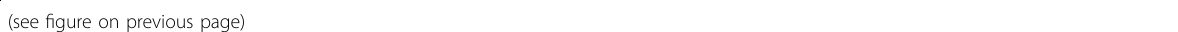
Fig. 3 Humanized anti-RGMa antibodies suppress MPTP-induced neuronal loss and in fl ammation. A Schematic representation of the timeline of MPTP injection and humanized antibody treatment. B Immuno fl uorescent staining for TH in the SN at 2 days (top), 7 days (middle), and 21 days (bottom) after the last MPTP injection. Scale bar, 200 μ m. C Changes in the numbers of TH-positive cells in the SN of MPTP-injected mice with anti- RGMa antibody or Palivizumab (as control) treatment at 21 days after the last MPTP injection. n = 9 – 10. * P < 0.05, Welch ’ s t test. D , E Stereology counts of TH-positive neurons in the SN from mice with anti-RGMa antibody or control (Palivizumab) treatment at 2 days ( D ) and 7 days ( E ) after the last MPTP injection. n = 5 – 6 ( D ), n = 5 – 7 ( E ). * P < 0.05, ** P < 0.01, *** P < 0.005, two-way ANOVA with Bonferroni multiple comparison test. F Immuno fl uorescent staining for Nissl in the SN at 21 days after the last MPTP injection. Scale bar, 200 μ m. G Stereology counts of Nissl-positive neurons in the SN from mice with anti-RGMa antibody or control (Palivizumab) treatment at 21 after the last MPTP injection. n = 4 – 6. ** P < 0.01, *** P < 0.005, two-way ANOVA with Bonferroni multiple comparison test. H Immuno fl uorescent staining for Iba1 in the SN at 2 days (top), 7 days (middle), and 21 days (bottom) after the last MPTP injection. Scale bar, 100 μ m. I Changes in the numbers of Iba1-positive cells in the SN of MPTP- injected mice with anti-RGMa antibody or Palivizumab treatment at 21 days after the last MPTP injection. n = 5 – 6. * P < 0.05, Student ’ s t test. J , K Stereology counts of Iba1-positive neurons in the SN of mice with anti-RGMa antibody or control (Palivizumab) treatment at 2 days ( J ) and 7 days ( K ) after the last MPTP injection. n = 5 – 6 ( J ), n = 5 – 7 ( K ). * P < 0.05, one-way ANOVA with Bonferroni multiple comparison test. L Immuno fl uorescent staining for cleaved caspase3 in the SN at 7 days (top) and 21 days (bottom) after the last MPTP injection. Scale bar, 50 μ m. M , N Stereology counts of cleaved caspase3-positive cells in the SN of mice with anti-RGMa antibody or control (Palivizumab) treatment at 7 days ( M ) and 21 days ( N ) after the last MPTP injection. n = 4 – 6 (M), n = 4 – 5 ( N ). * P < 0.05, ** P < 0.01, *** P < 0.005, one-way ANOVA with Bonferroni multiple comparison